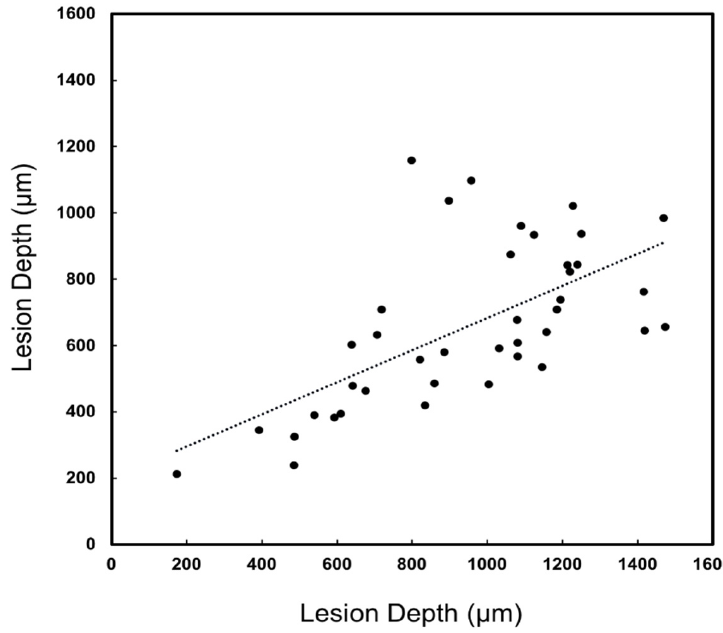
Figure 5. The lesion depth was measured in proximal transillumination mode (X pt ) and microCT (X µ ). There was a significant correlation between the two methods ( p < 0.05) with R 2 = 0.40 and 40 of the 67 lesions had sufficient contrast to perform the measurements.